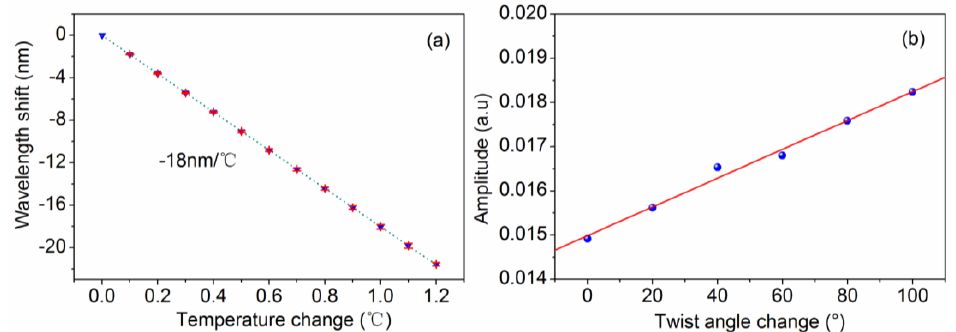
Figure 6. ( a ) Temperature responses of the Lyot-Sagnac interferometer under different twist angles; ( b ) Torsion responses of the Lyot-Sagnac interferometer-based sensor.